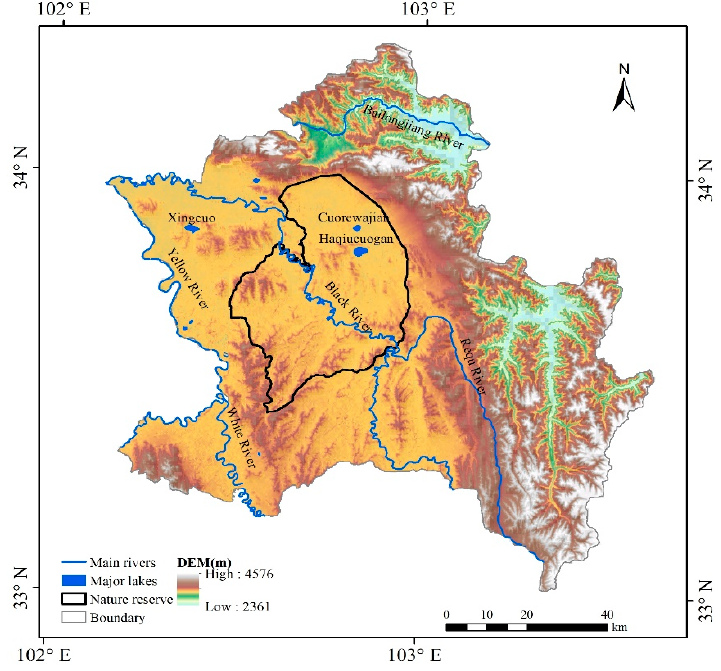
Figure 1. Topographical map of Zoige County.